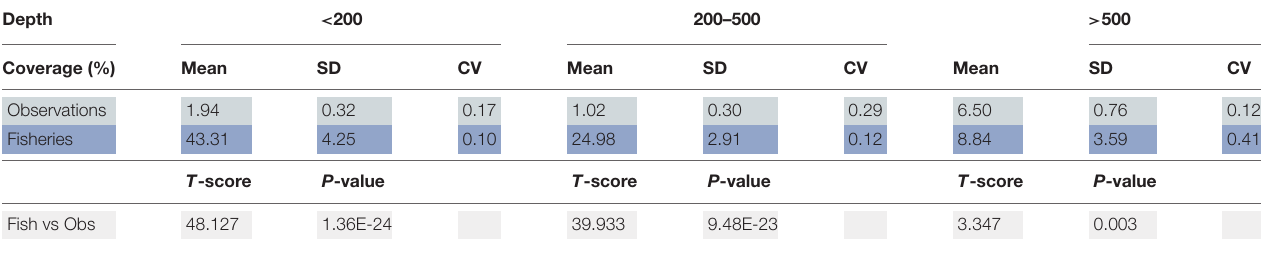
TABLE 3 | Summary statistics comparing observation and fisheries coverage in the North Atlantic focus region.